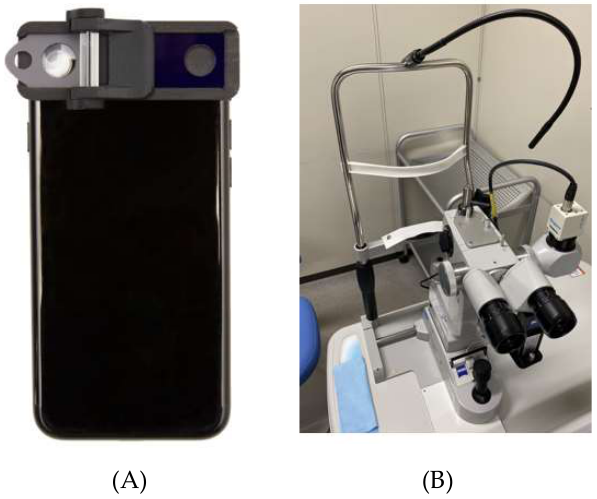
Figure 2. Appearance of ( A ) the SEC and ( B ) the conventional slit-lamp microscope.